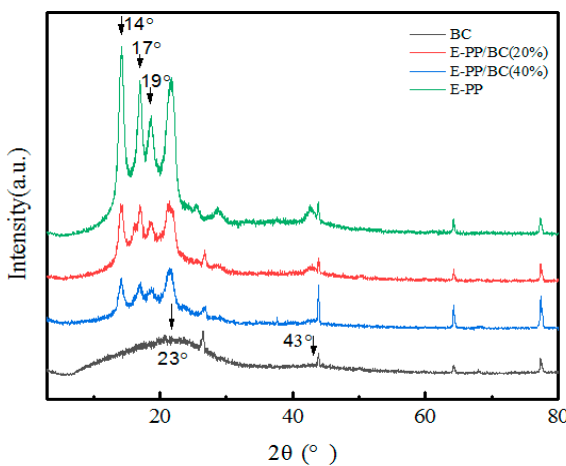
Figure 5. XRD patterns of BC, E-PP, and foamed E-PP/BC (20 wt.% and 40 wt.%) compo- sites.